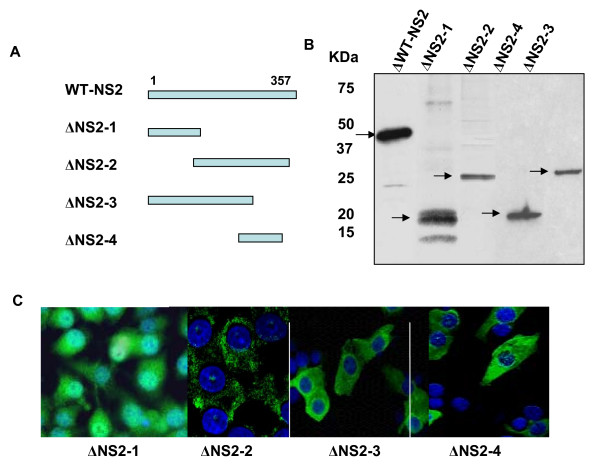
Expression of NS2 mutants constitutively in BSR cells. (A) Schematic representation of various NS2 carboxyl- and amino-terminal deletions used to produce inducible mammalian cell line (BSR). (B) Immunoprecipitation of radiolabeled proteins. Radiolabeled cell lysates of the different NS2 cell lines (BSR) were immunoprecipited using polyclonal anti-NS2 antibody. The names of the cell lines are given at the top of the panel. The positions of the various NS2 fragments are indicated. (C) Intracellular distribution of NS2 fragments (green) in inducible NS2 cell lines (BSR). The name of each mutant is indicated.